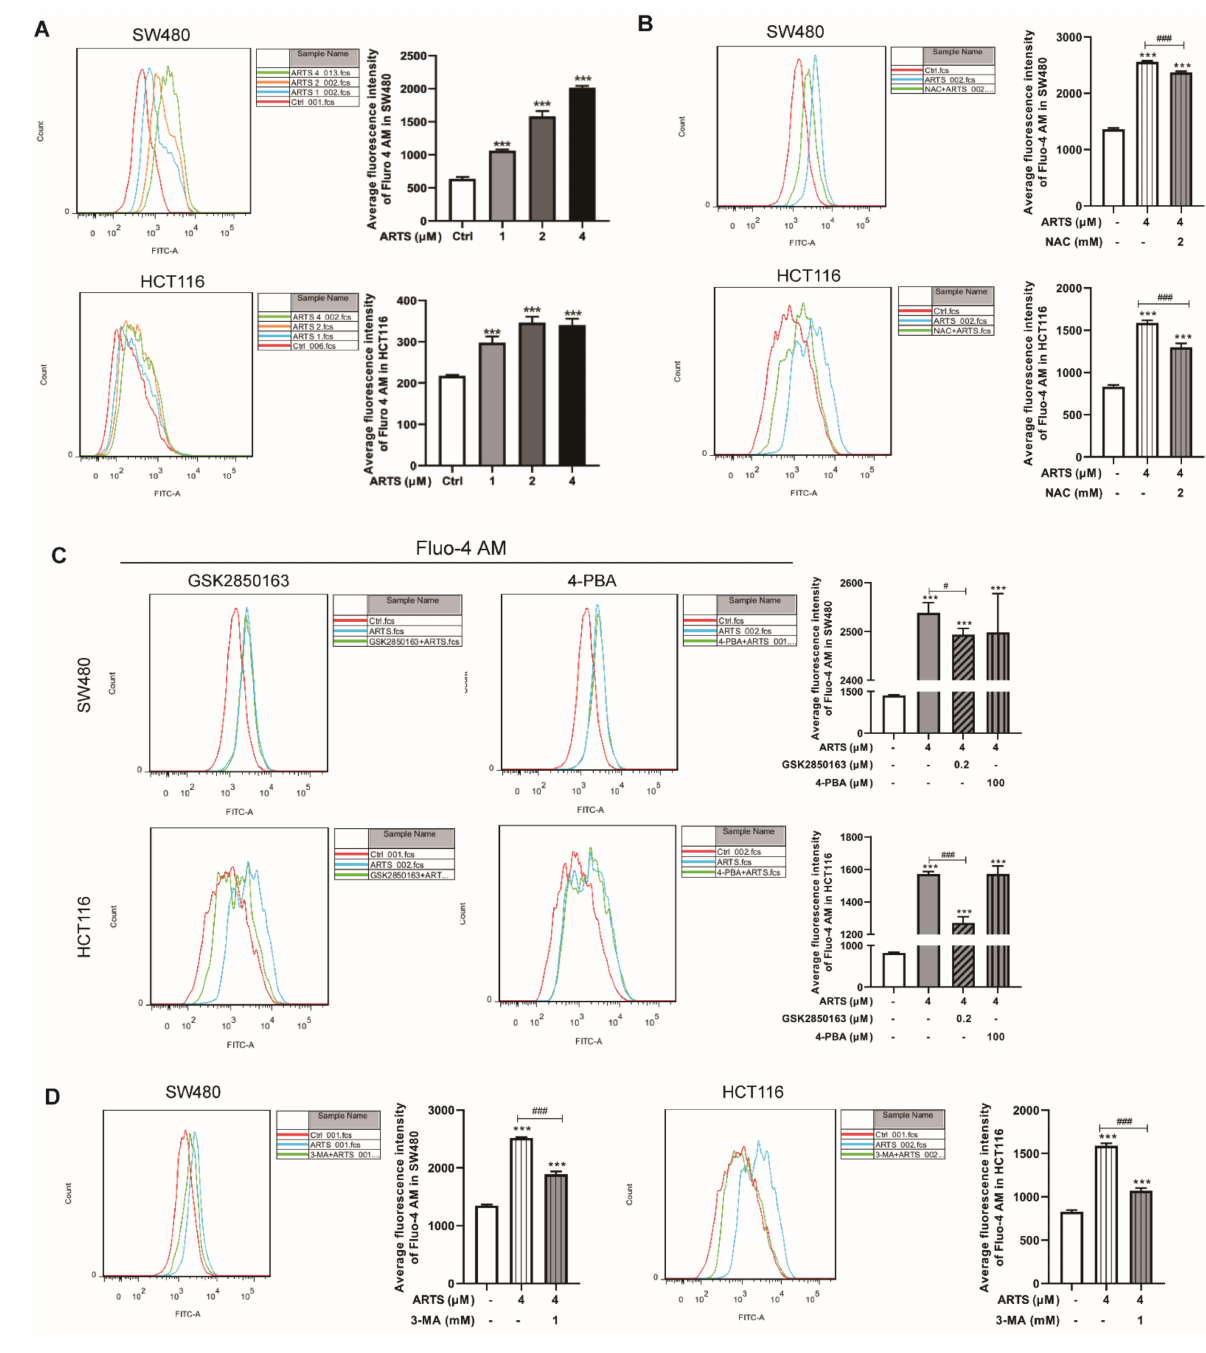
Figure 7. ( A ) Artesunate increased the cellular free Ca 2+ level markedly. After artesunate treatment, cells were probed with Fluo 4-AM and analyzed by flow cytometry. The green fluorescence intensity of Fluo 4-AM represented cellular free Ca 2+ level. ( B ) ROS scavenger NAC, ( C ) IRE1 α inhibitor GSK2850163, and ( D ) autophagy inhibitor 3-MA helped to reduce cellular free Ca 2+ level. *** p < 0.001 vs. Ctrl. # p < 0.05, ### p < 0.001 vs. cells treated with artesunate alone. Data were shown as mean ± SD. As shown in Figure 7B, the fluorescence intensity of Fluo 4-AM in SW480 and HCT116 cells was decreased by approximately 7.30% ± 0.36% ( p < 0.001) and 18.10% ± 2.64% ( p < 0.001), respectively, due to NAC